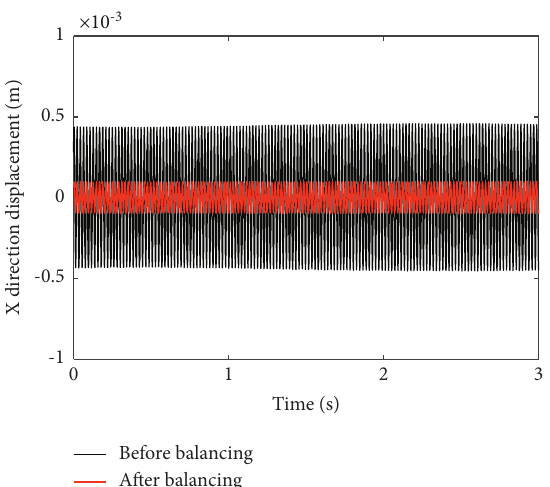
Figure 17: Steady-state vibration response of the measuring point before and after balancing by the ICM